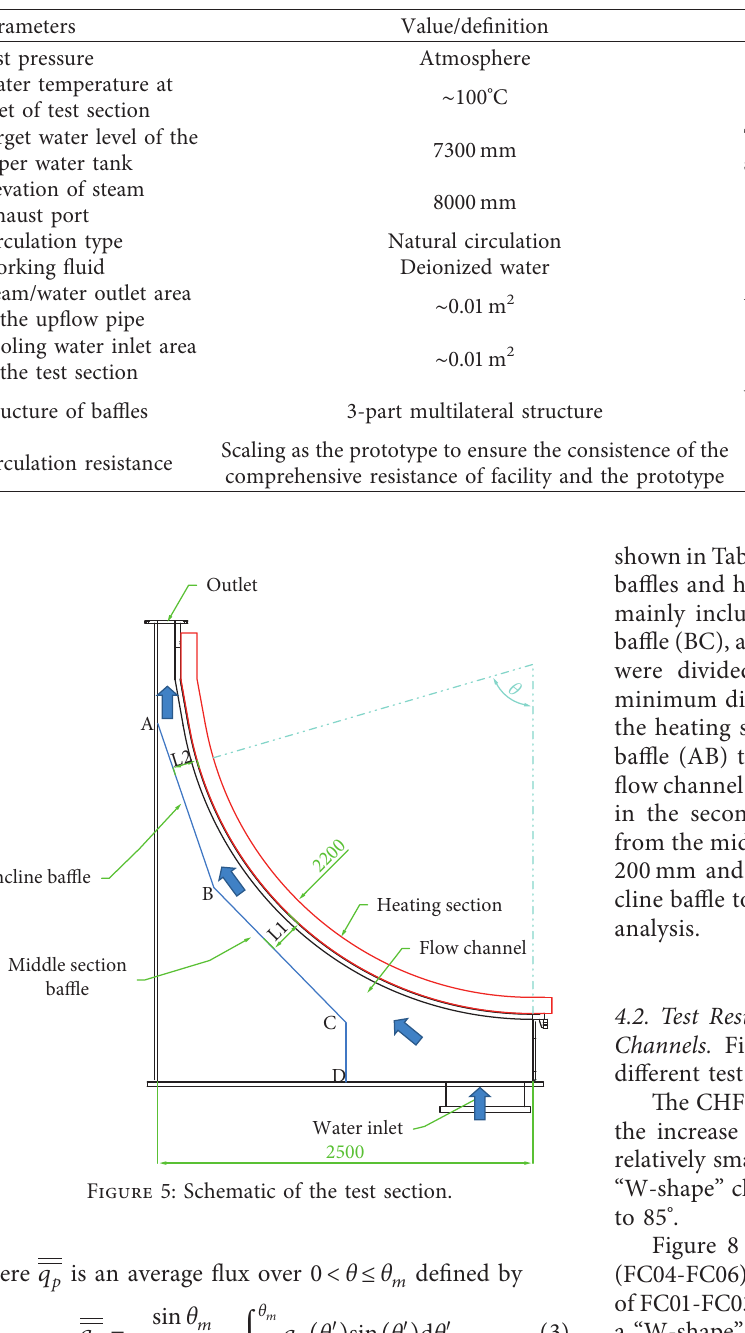
Table 1: Key parameters of REVECT facility.